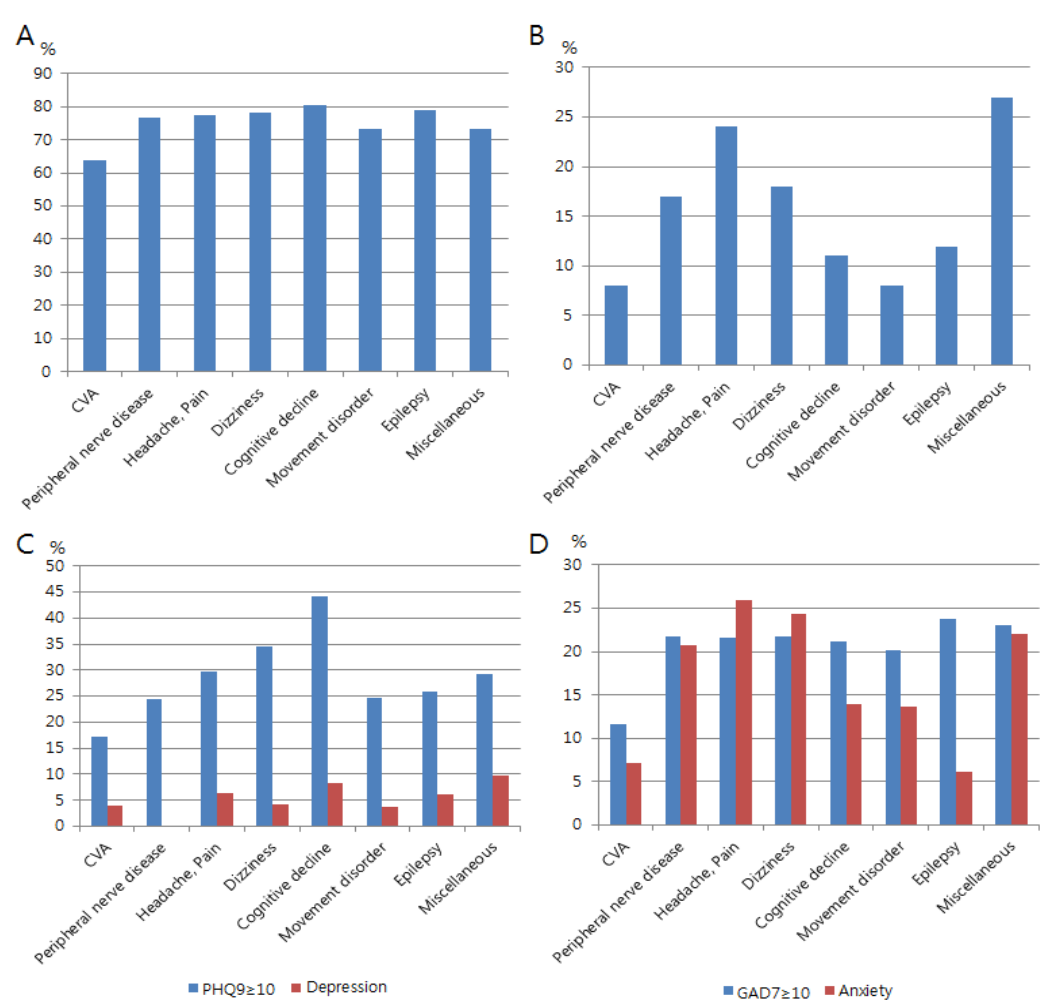
Figure 1. Psychiatric symptoms according to neurological disease subtypes: ( A ) moderate to severe perceived stress scale (PSS ≥ 14); ( B ) frequency of insomnia; ( C ) moderate to severe depression (PHQ9 ≥ 10, blue bars) and diagnosed depression (red bars); ( D ) moderate to severe anxiety (GAD7 ≥ 10, blue bars) and diagnosed anxiety (red bars).